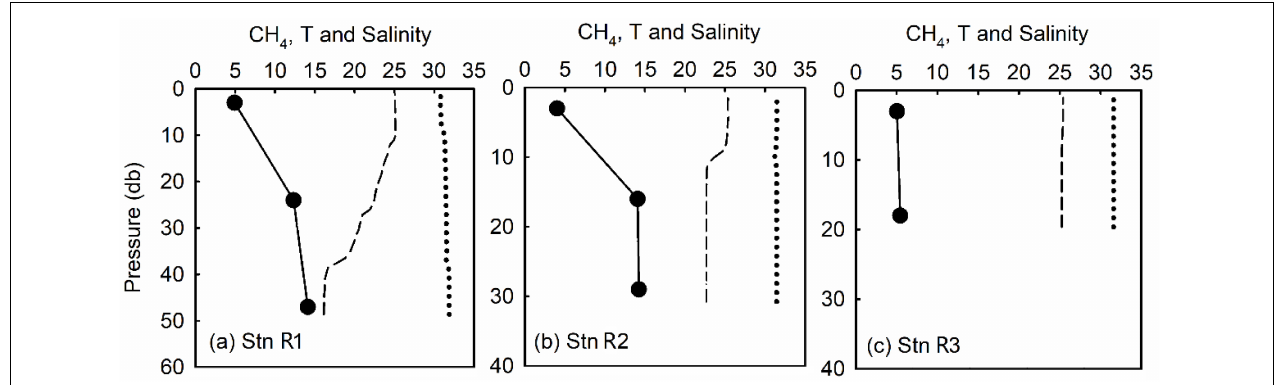
FIGURE B1 | Vertical profiles of [CH 4 ] (nmol kg − 1 , filled circles in black) (a) , temperature ( ◦ C, dashed lines) (b) , and salinity (dotted lines) (c) at reference stations off the Bohai